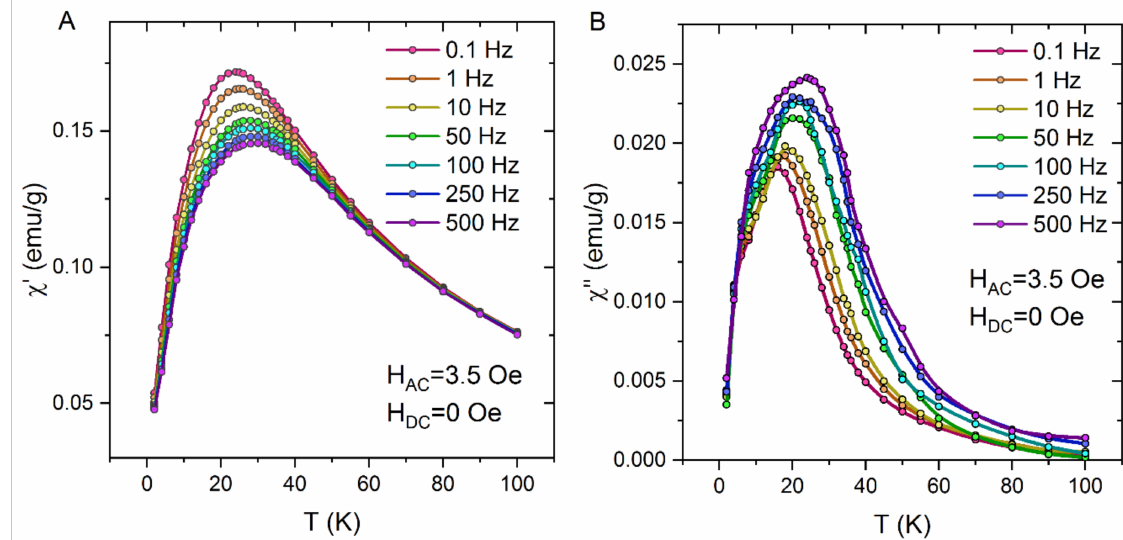
Figure 7. Real ( A ) and imaginary ( B ) AC susceptibility data for Fe 3 O 4 nanoparticles.